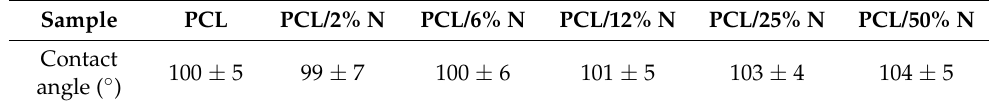
Table 3. Contact angle values of investigated